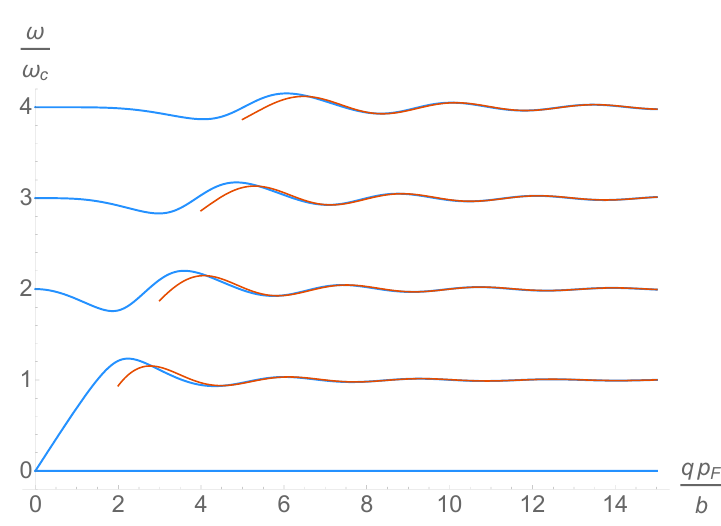
Figure 2 . Improved asymptotics for the dispersion